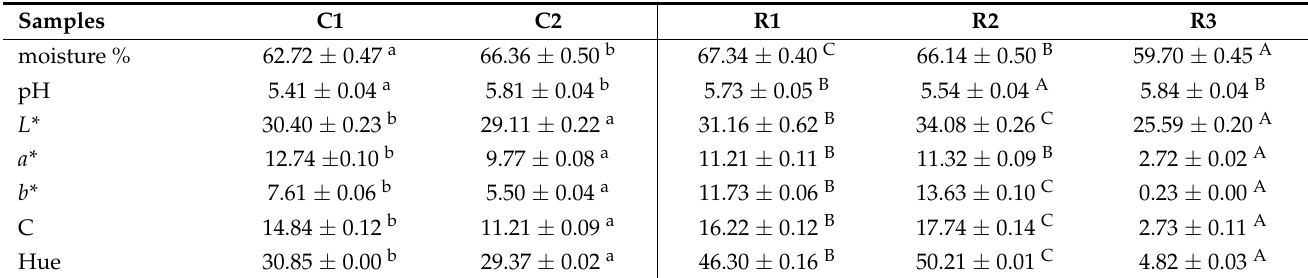
Table 2. Chemical–physical parameters determined in different anchovies sauces’ samples. Different superscript letters between means within a row indicate statistically significant differences at p < 0.05. Lower-case letters are used for comparing C1–C2 (commercial samples); upper-case letters are used for R1–R2–R3 samples at 12-, 24-, and 48-month